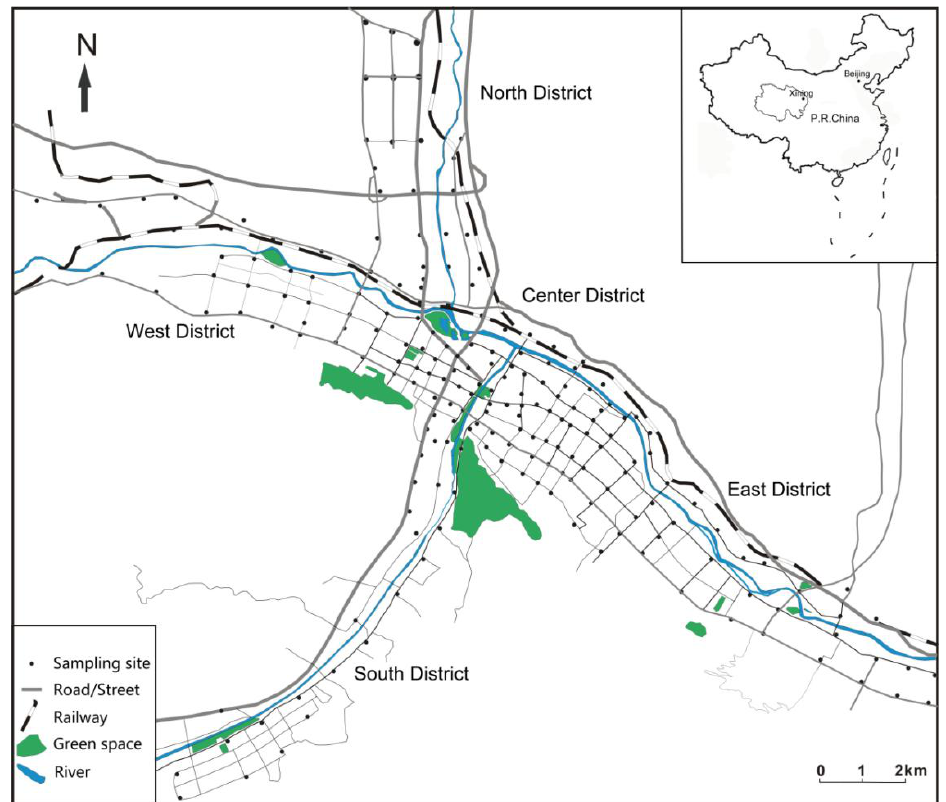
Figure 1. Study area and sampling sites in